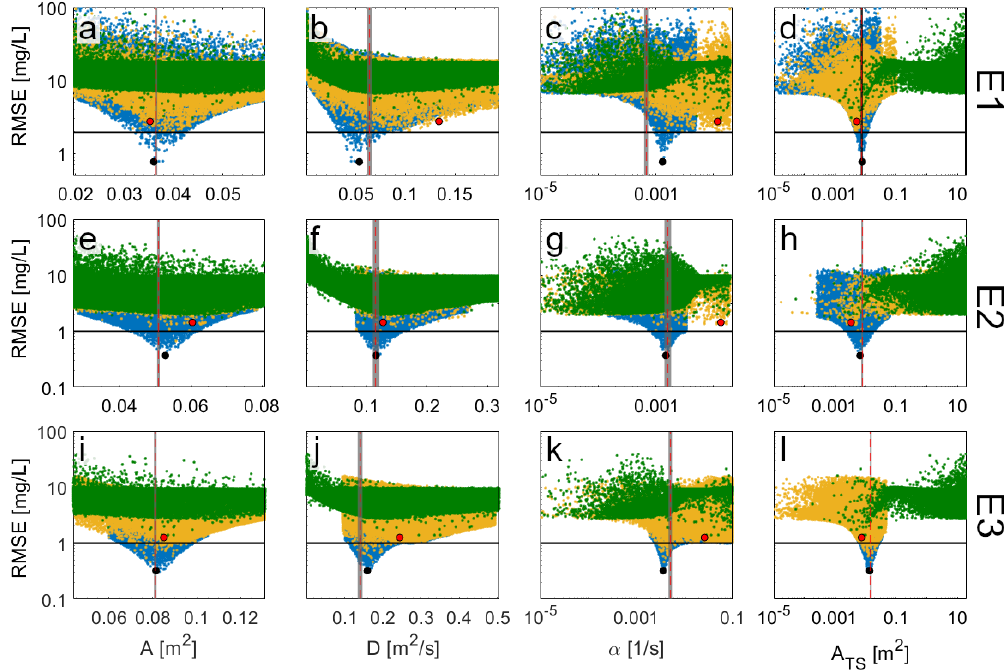
Figure 3. Same as Fig. 2 but reporting TSM results when velocity was considered equal to v peak